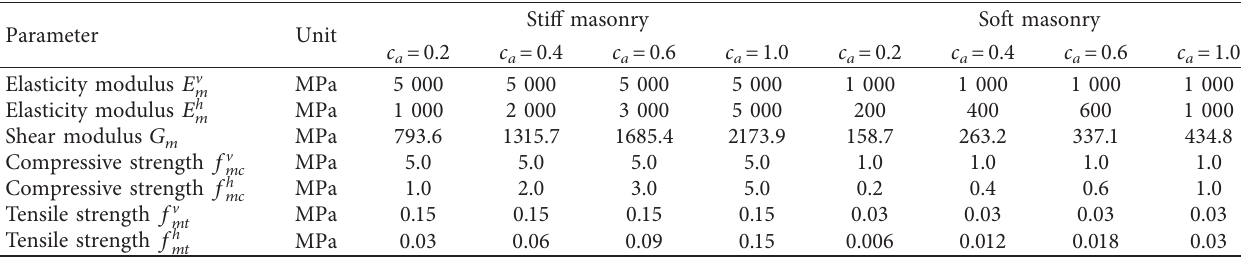
Table 3: Adopted basic material parameters for masonry.